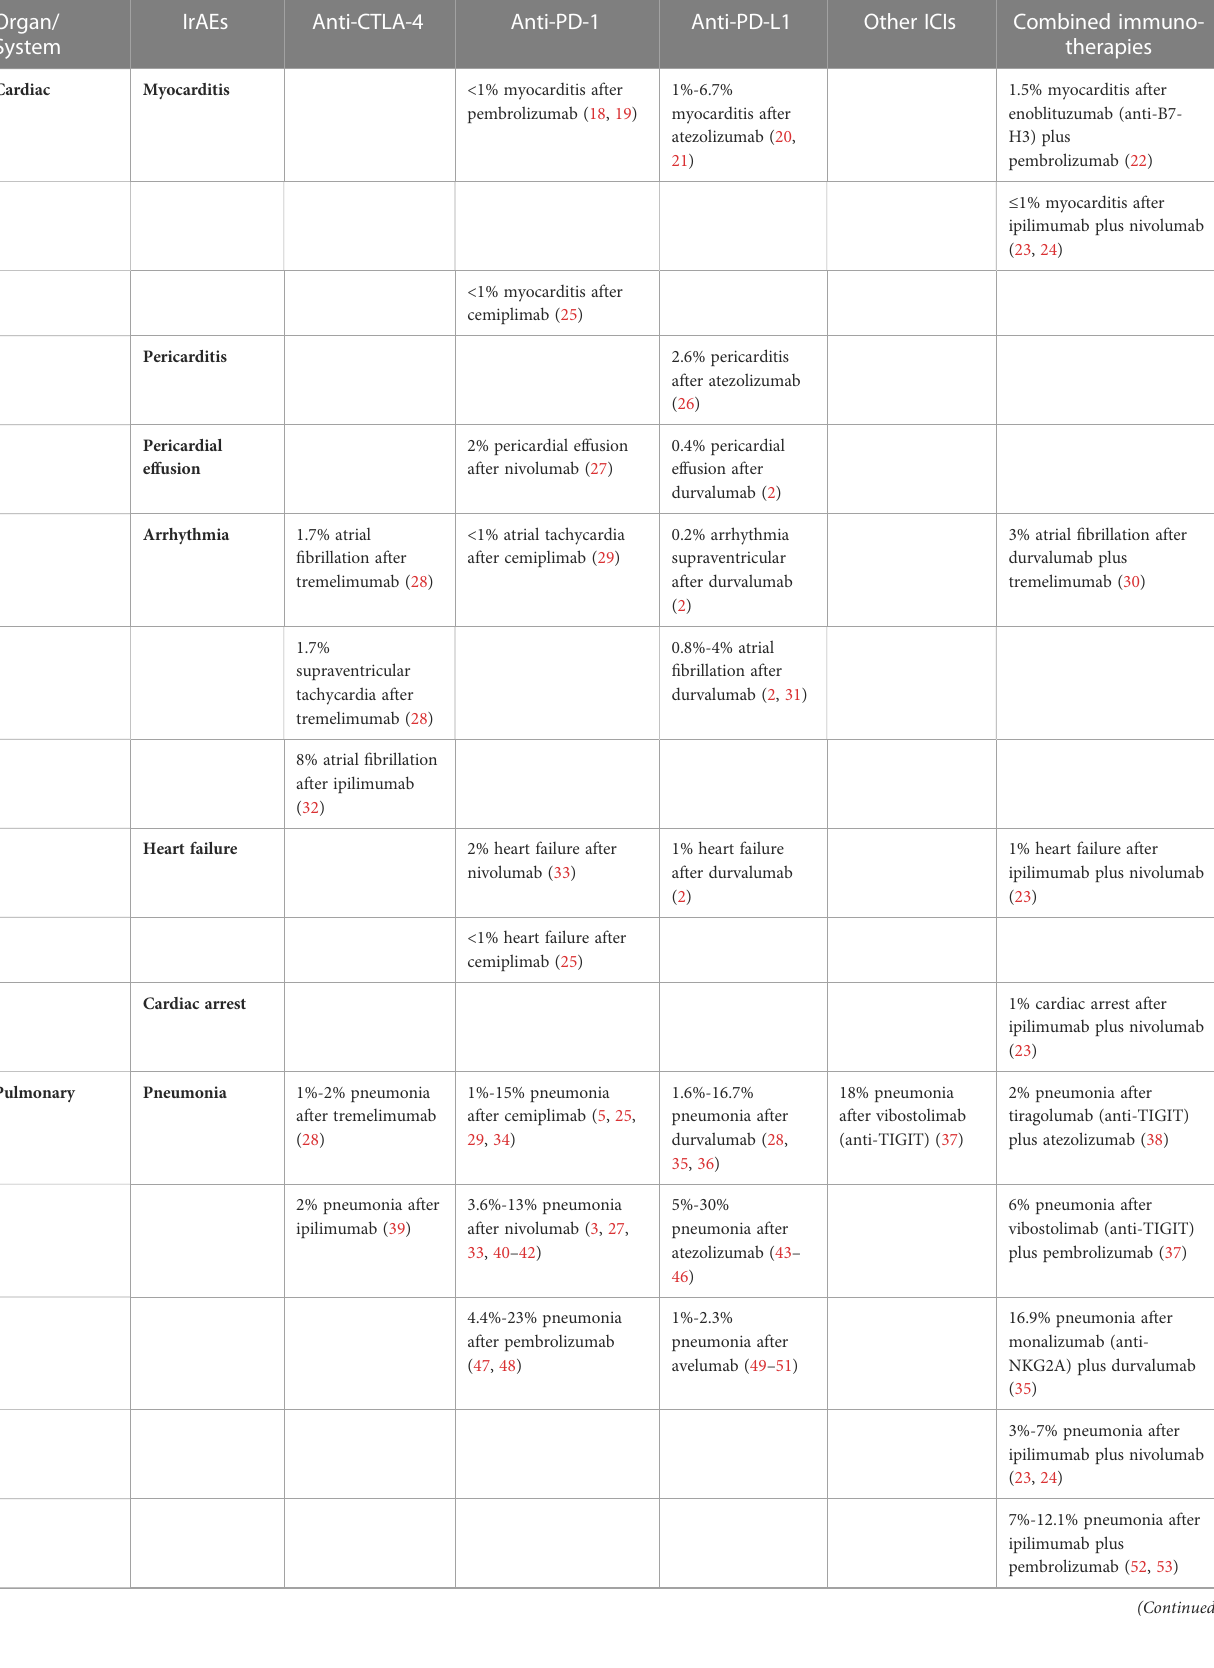
TABLE 1 Clinical manifestations of common